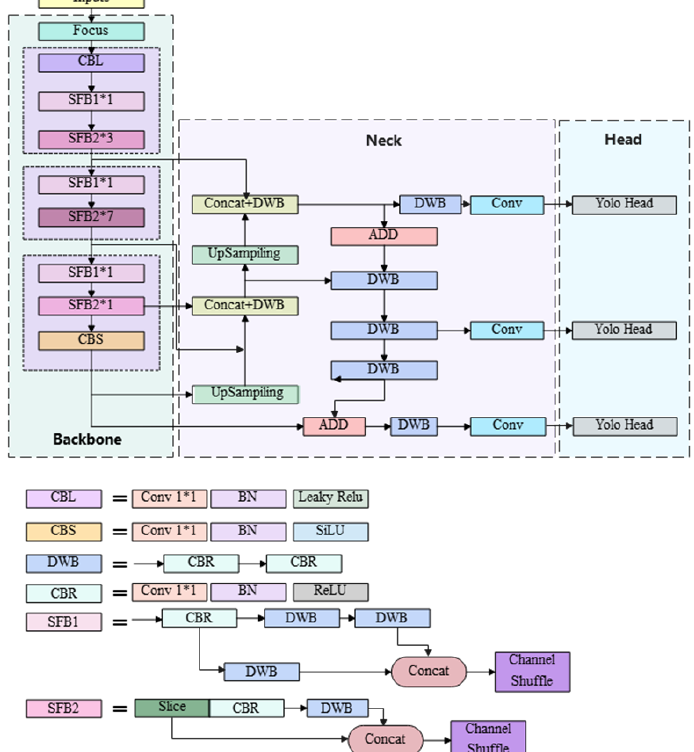
Figure 5. YOLOv5 network improvement